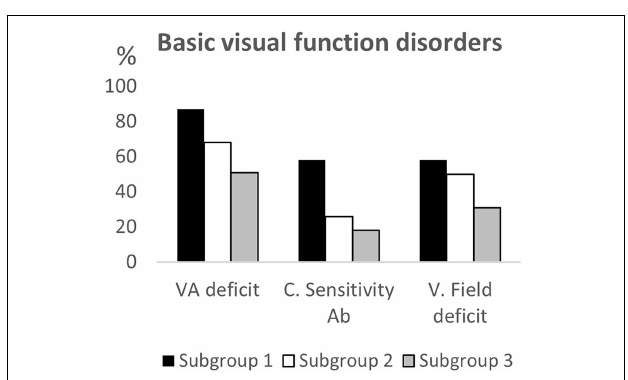
FIGURE 3 | Basic visual function disorders according to age subgroups. VA deficit, visual acuity deficit; C. Sensitivity Ab, Contrast Sensitivity abnormalities; V. field deficit, visual field deficit.